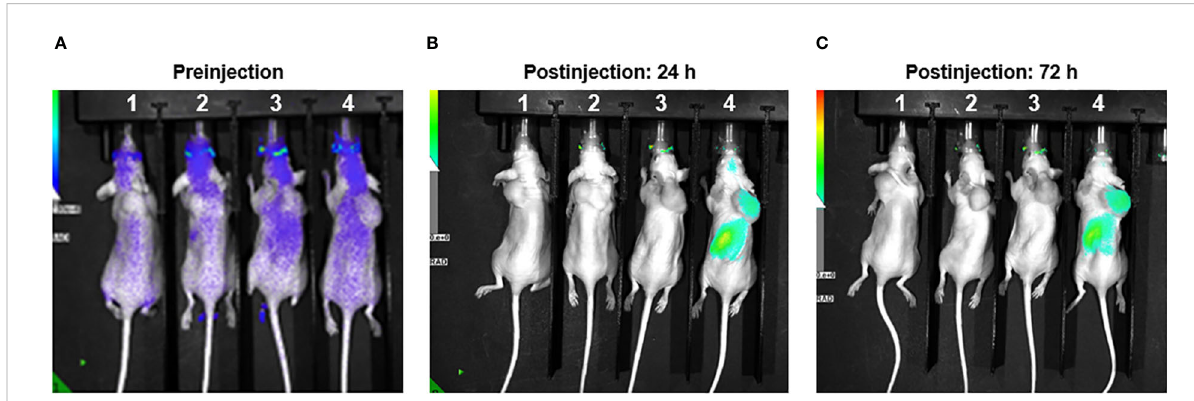
FIGURE 8 RAW.264.7 M1 polarized vesicles localize to SKOV3 tumor xenografts in vivo via an intraperitoneal route. (A) Four athymic nude mice displayed – each with SKOV3 tumor xenograft in the dorsal shoulder region. Image taken preinjection for comparison purposes. (B) Mice 1 & 2 injected with 200ul of sterile PBS. The two mice on the right were injected with 50ul (Mouse 3) and 100ul (Mouse 4) of DiR labeled vesicles and imaged 24 hours post-injection. There is clear localization of fl uorescent uptake in the vicinity of the tumor in the far-right mouse. The fl uorescent overlay was reduced to display visible tumor for comparison. (C) Same mice shown with clear and persistent fl uorescent uptake seen in far-right mouse ’ s